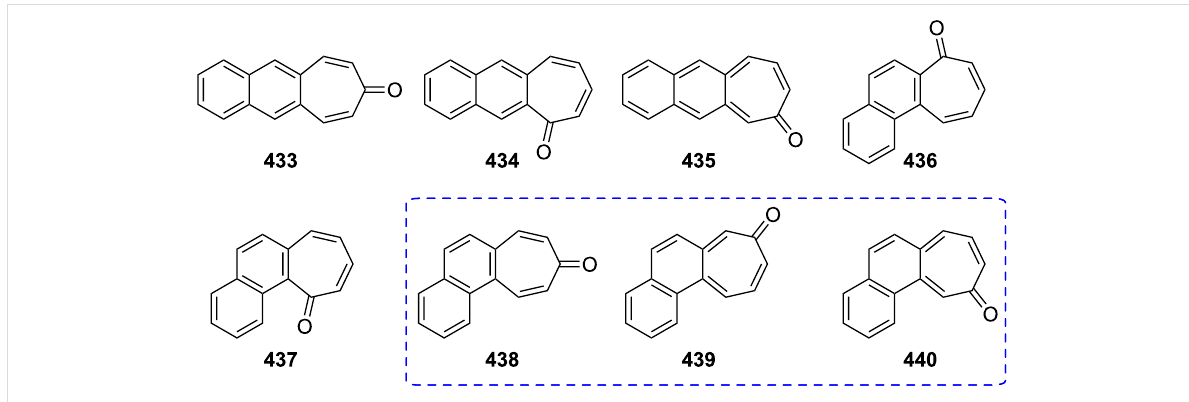
Figure 28: Structures of possible eight isomers 433 – 440 of naphthotropone.